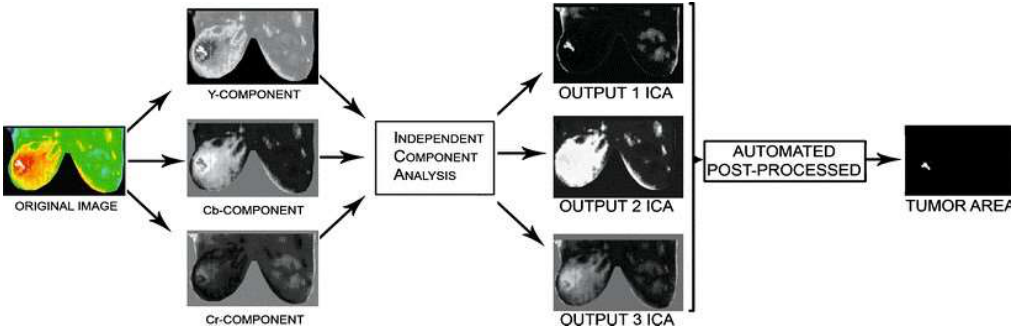
Figure 5. The overview of the ICA process combined with automated post-processing, used to detect a tumor in the breast more effectively [28].